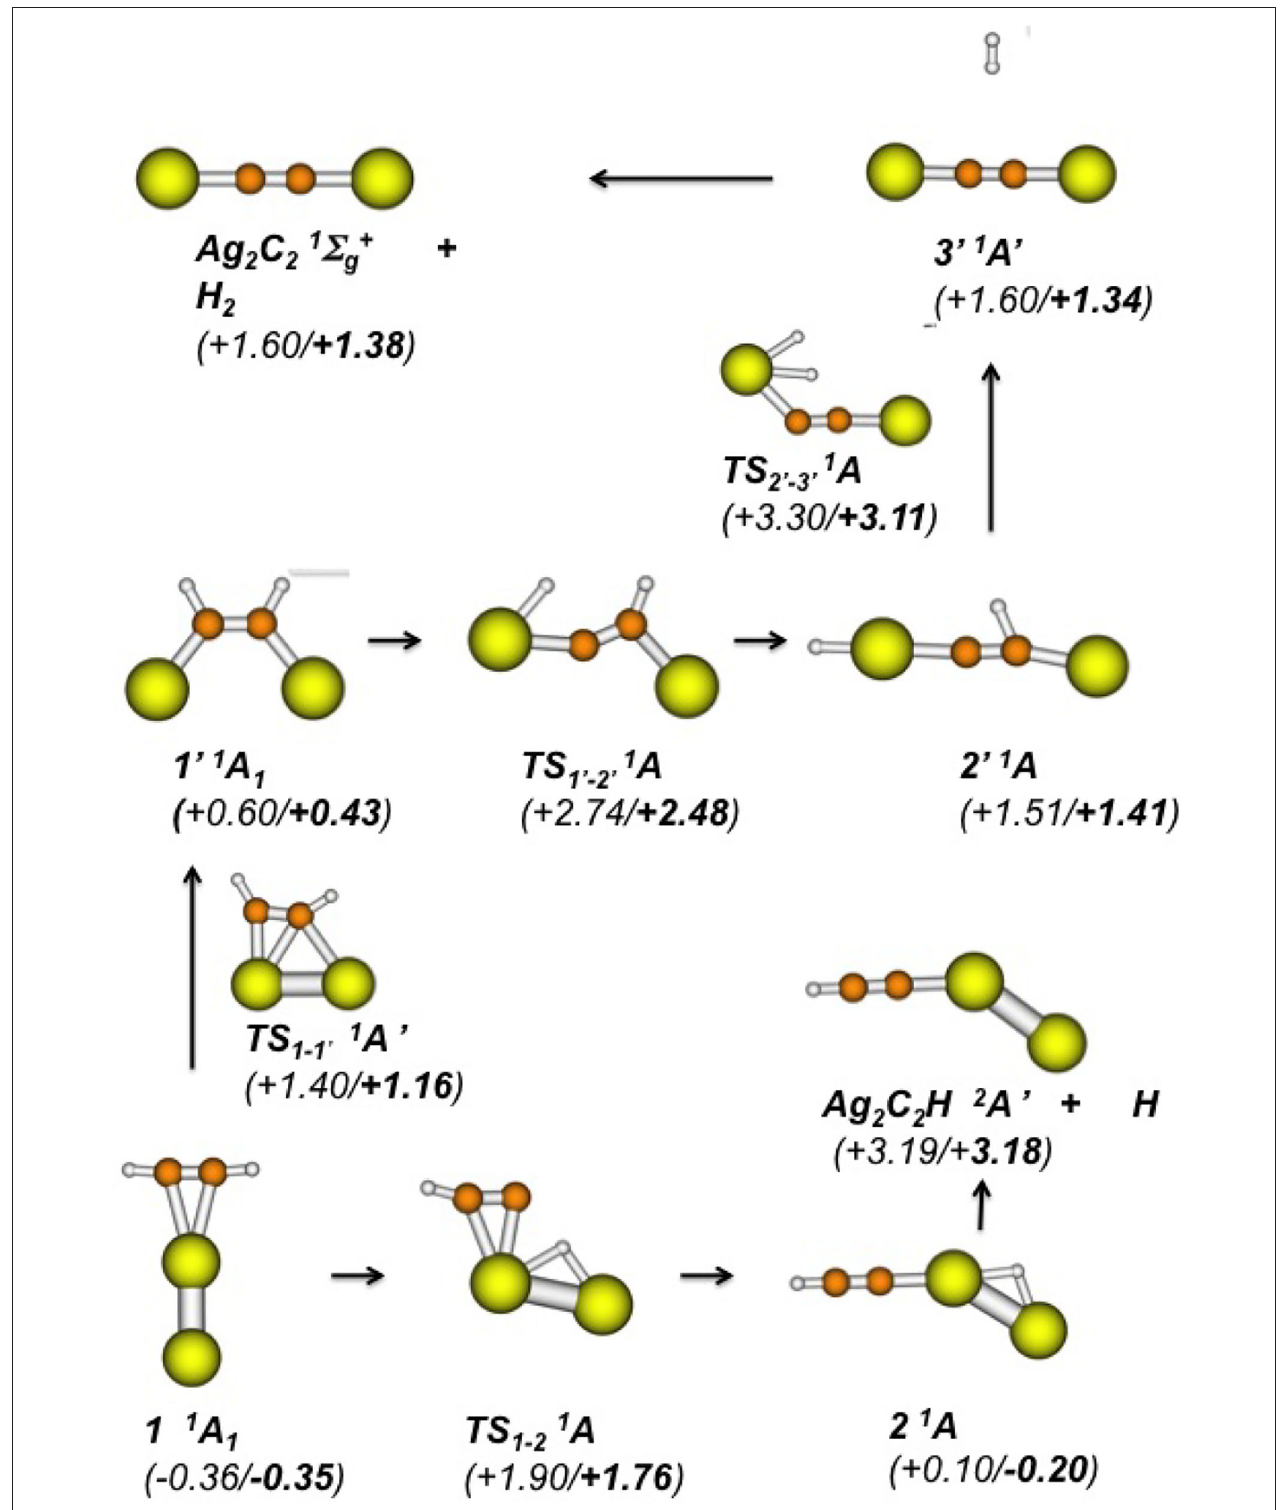
FIGURE 8 | Calculated possible intermediates and transition states leading to the loss of H (bottom) and H 2 (top) from Ag 2 C 2 H 2 (structure 1; Ag atoms are yellow). The electronic states are reported, and the DFT relative enthalpies at 0K with respect to Ag 2 + C 2 H 2 in their ground electronic states are reported in eV in parentheses, along with CCSD(T) single point values in bold characters. For TS 1 − 1 ′ , no IRC path could be computed due to convergence problem.